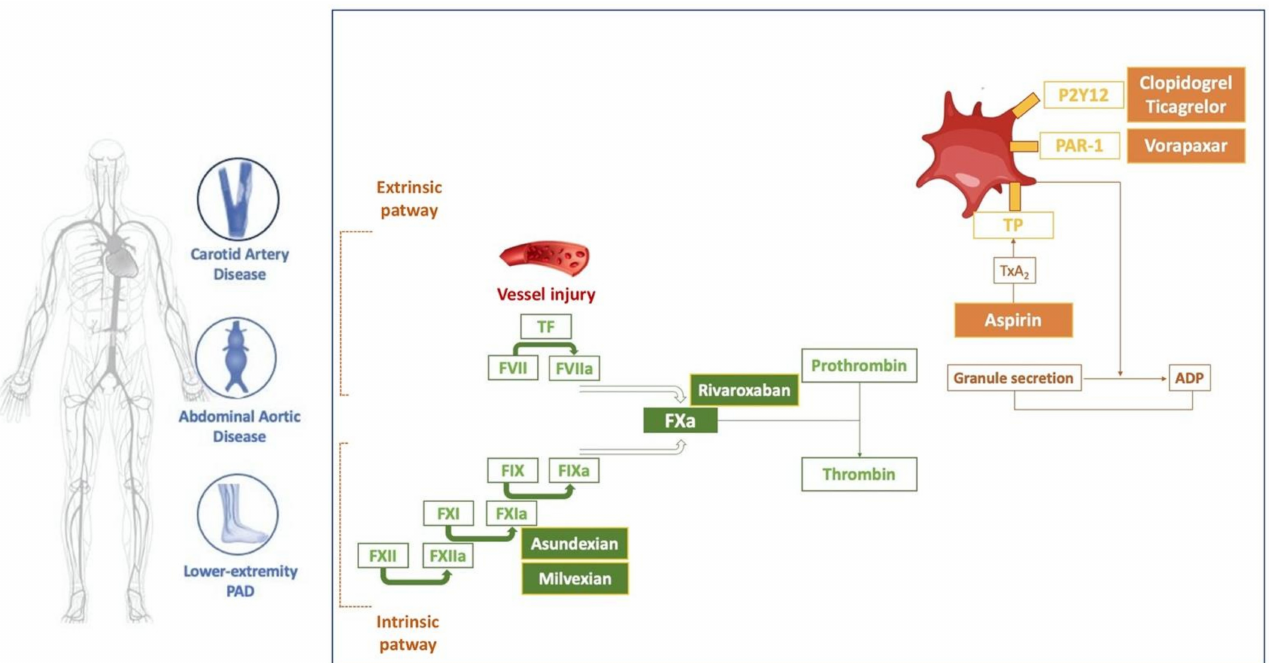
Figure 1. Pharmacodynamic targets of antithrombotic drugs in peripheral artery disease by throm- botic pathway. TF = tissue factor, TxA 2 = Thromboxane A2, TP = thromboxane prostanoid, PAR-1 = protease-activated receptor-1, ADP = adenosine